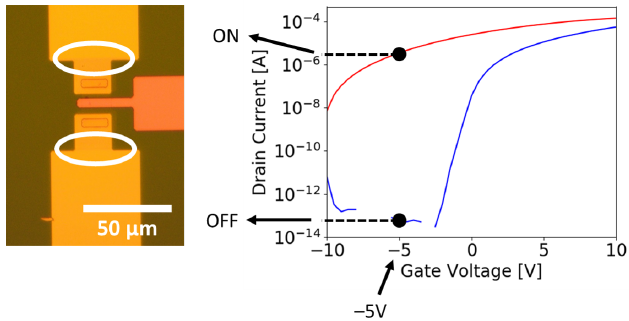
Figure 12: Microscope image and I d - V g graph of a transistor, corresponding to a laser configuration that changes the state of the transistor from off to on when the gate voltage is -5 V. The blue line indicates the current before lasering. The red line indicates the current after lasering. The laser is configured to an attenuation of 45 dB in low energy mode; one pulse is applied (Setting 1).